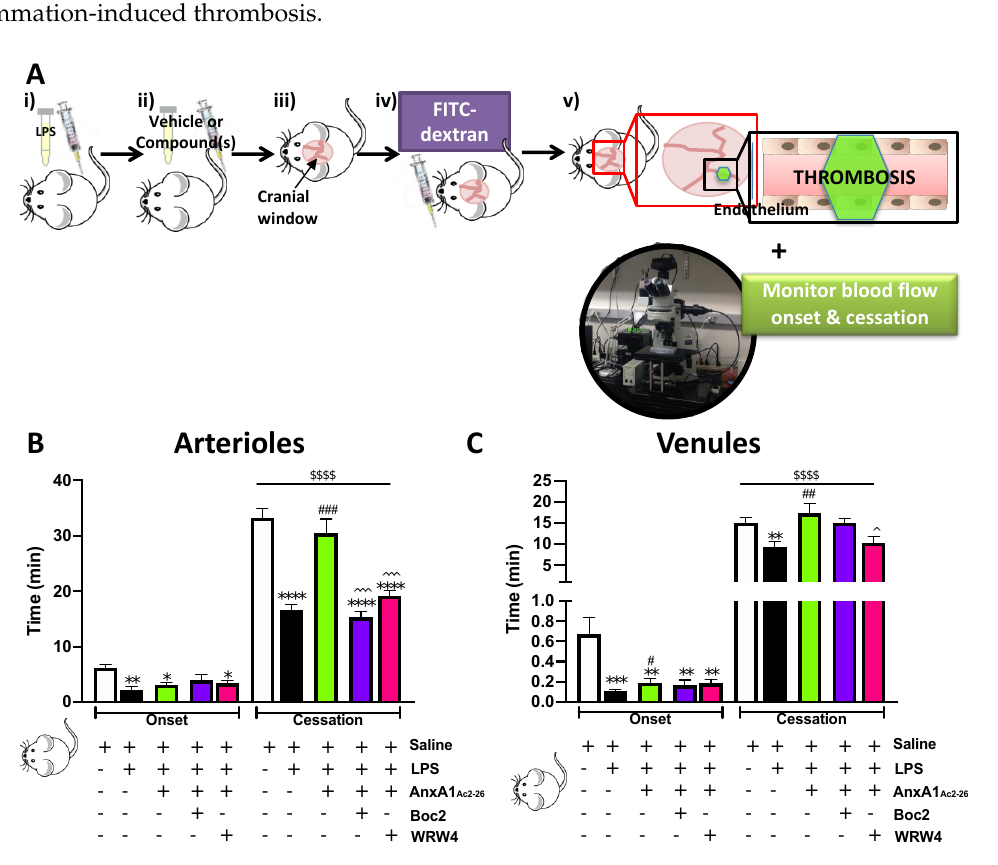
Figure 1. AnxA1 Ac2-26 protects against the effects of endotoxin (LPS) in light/dye-induced thrombosis responses in the cerebral microcirculation. ( A ) Schematic showing the experimental protocol: (i) Mice (C57BL / 6) were subjected to vehicle (saline) or LPS (0.4 mg / kg) for 2 h. (ii) Mice were treated with vehicle (saline) or compound(s): AnxA1 Ac2-26 (4 mg / kg) with / without pan FPR antagonist Boc2 (0.4 mg / kg) or FPR2 / ALX antagonist WRW4 (2.2 mg / kg) 20 min prior to thrombosis. (iii) A cranial window was performed and (iv) fluorescein isothiocyanate (FITC)-dextran was injected (10 mg / kg of 5%). (v) Mice were subjected to intravital microscopy and light / dye-induced thrombus formation, with onset and blood flow cessation times recorded for cerebral ( B ) arterioles and ( C ) venules. Data are means ± SEM of 5–6 mice / group. * p < 0.05, ** p < 0.01, *** p < 0.001, **** p < 0.0001 vs. corresponding vehicle